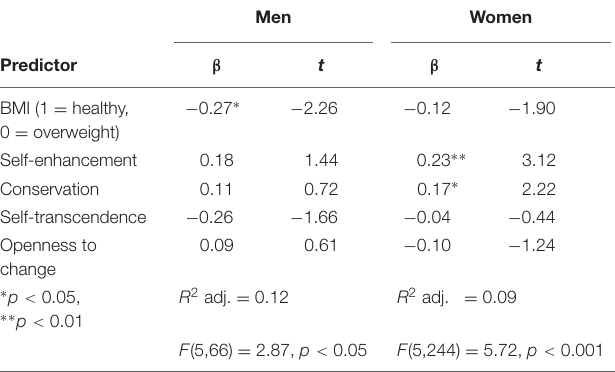
TABLE 3 | Multiple regression analysis predicting body shame.